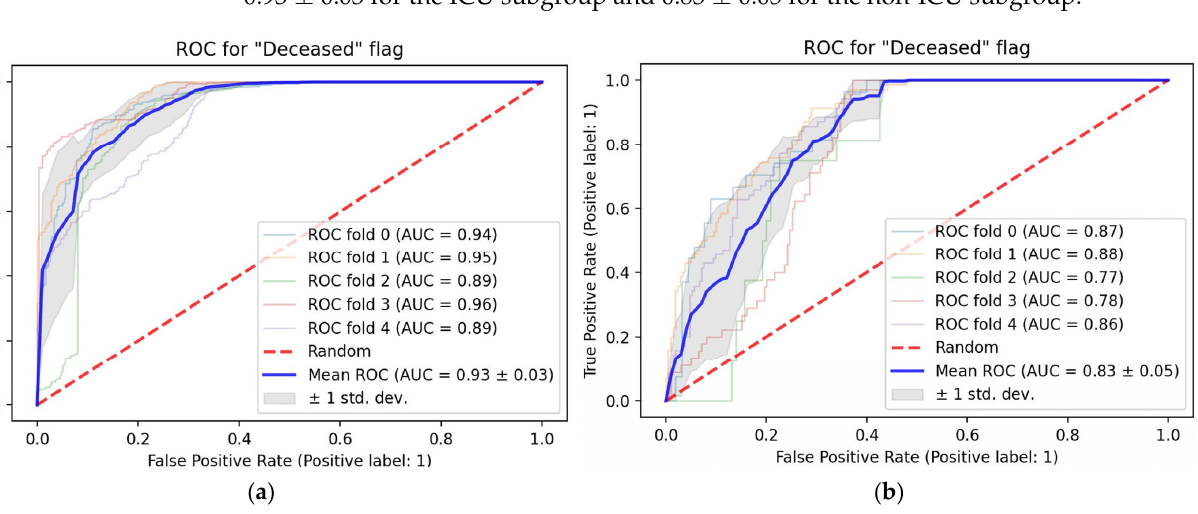
Figure 4. Pareto chart for the LIME analysis results for the predictive model using imaging and demographic and other clinical variables. Predictors are shown in order of descending mean con- tributions.